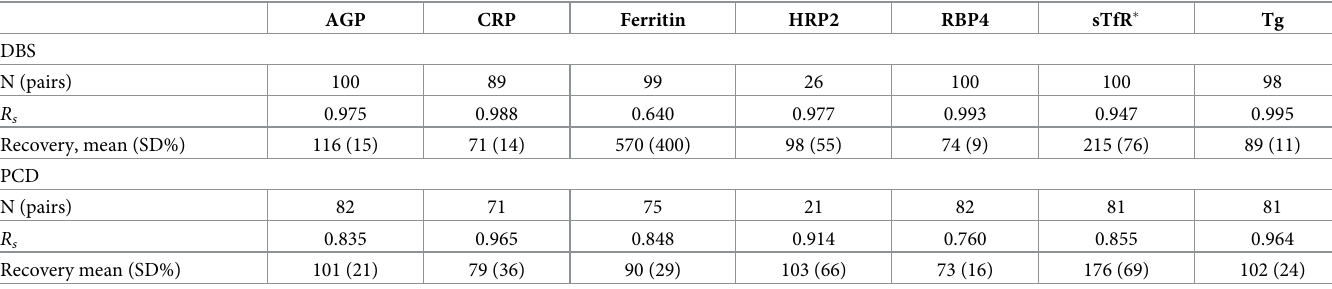
Table 3. The comparison of results for plasma, DBS and the volume adjusted PCD eluates using R s and recovery of expected plasma